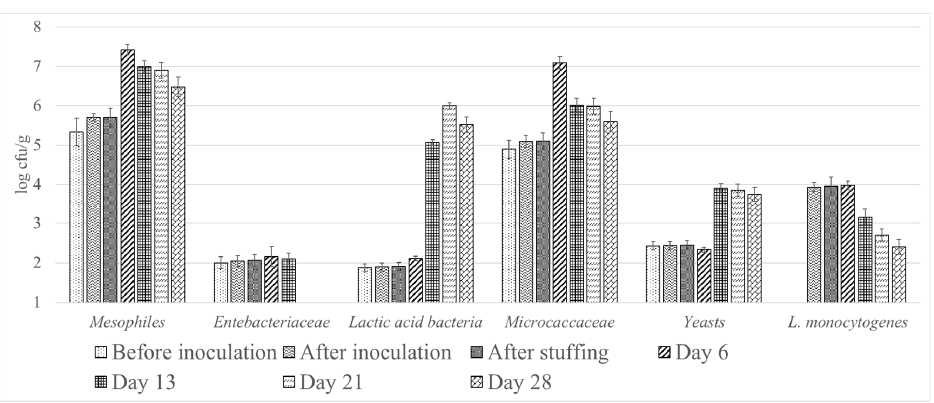
Figure 1. Evolution of the microbial groups in chorizo inoculated with L monoocytogenes during manufacturing. L. monocytogenes was not detected in the sausage mixture before inoculation.